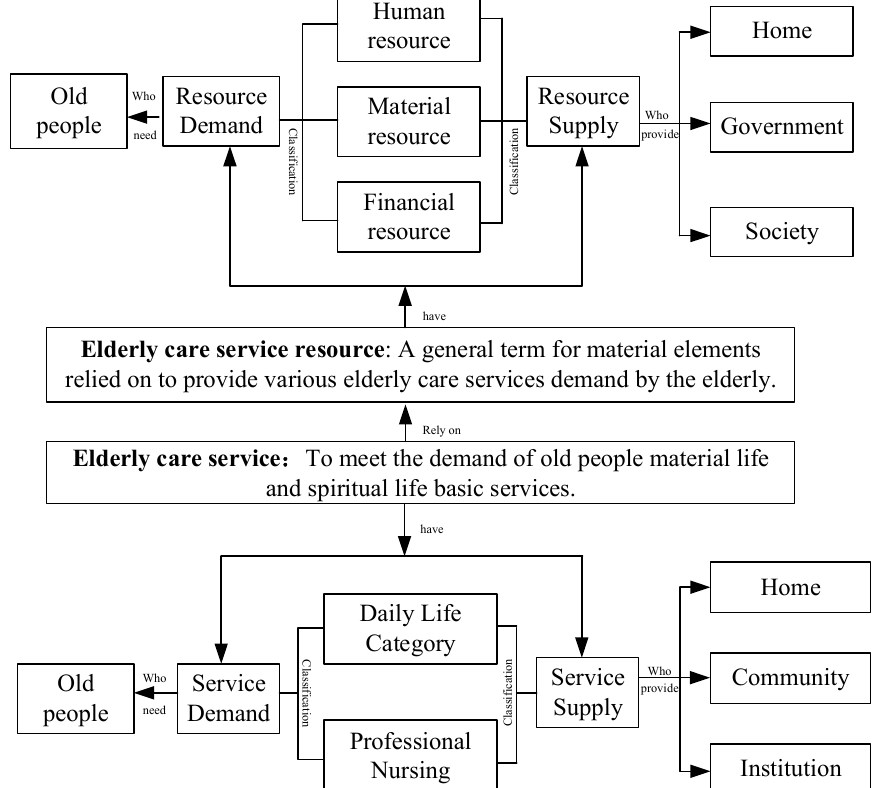
Figure 1. Schematic diagram of the relationship between the key concepts.